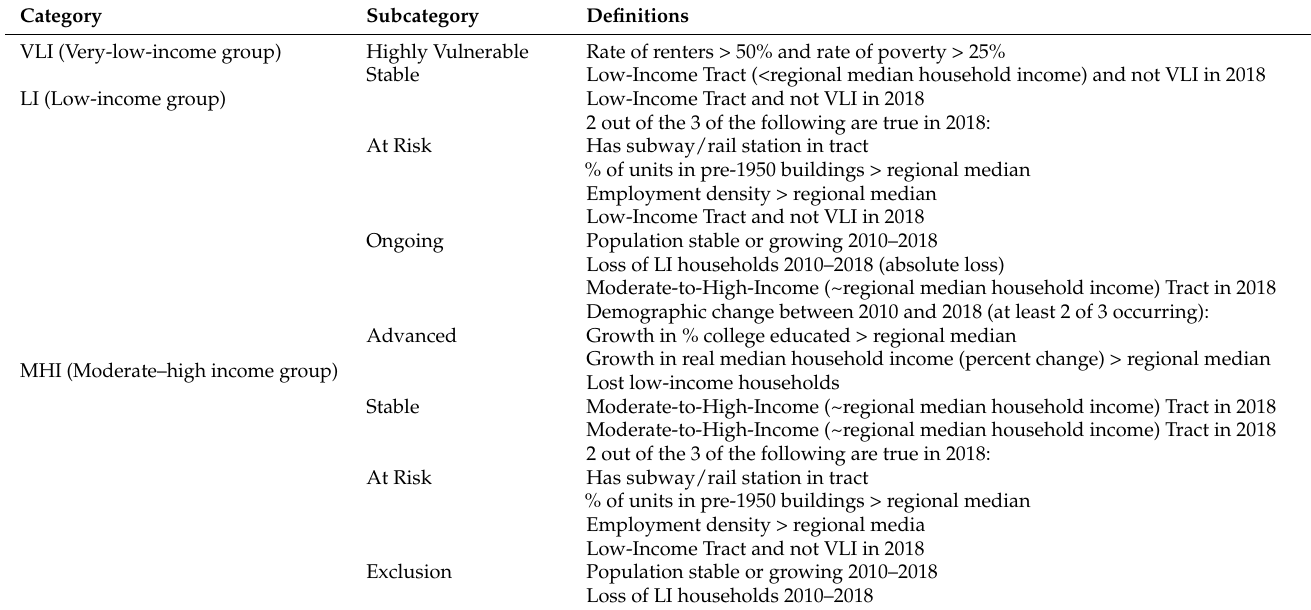
Table 2. Categories and subcategories of